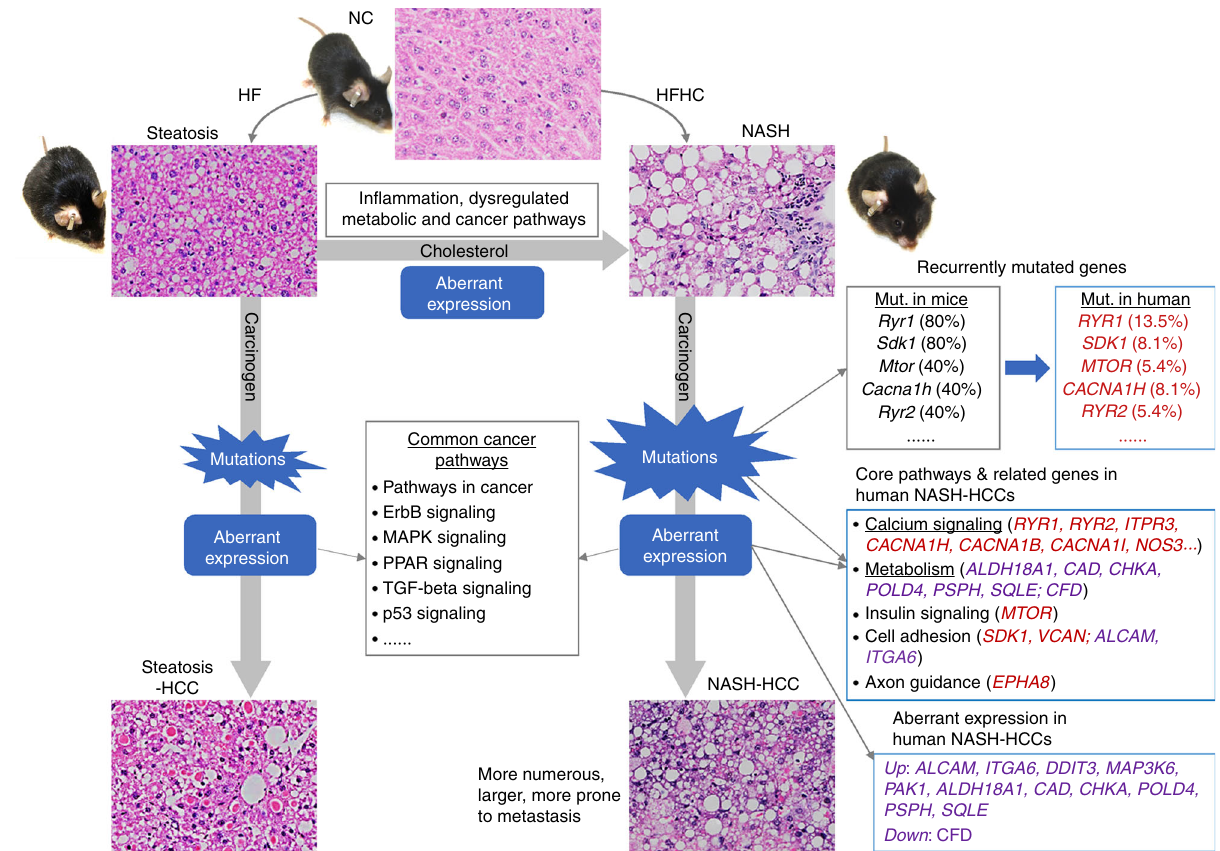
Fig. 8 Schematic summary of this study. NASH development promoted by dietary cholesterol is associated with aberrant gene expression linked with activated in fl ammatory signaling, dysregulated metabolic and cancer-related pathways. Dietary cholesterol-induced NASH-HCC development in mice is associated with aberrant gene expression, genomic mutations and the associated core pathways. The identi fi ed aberrant gene expression and mutations were veri fi ed in human NASH-HCCs. NC, normal chow; HF, high-fat diet; HFHC, high-fat high-cholesterol